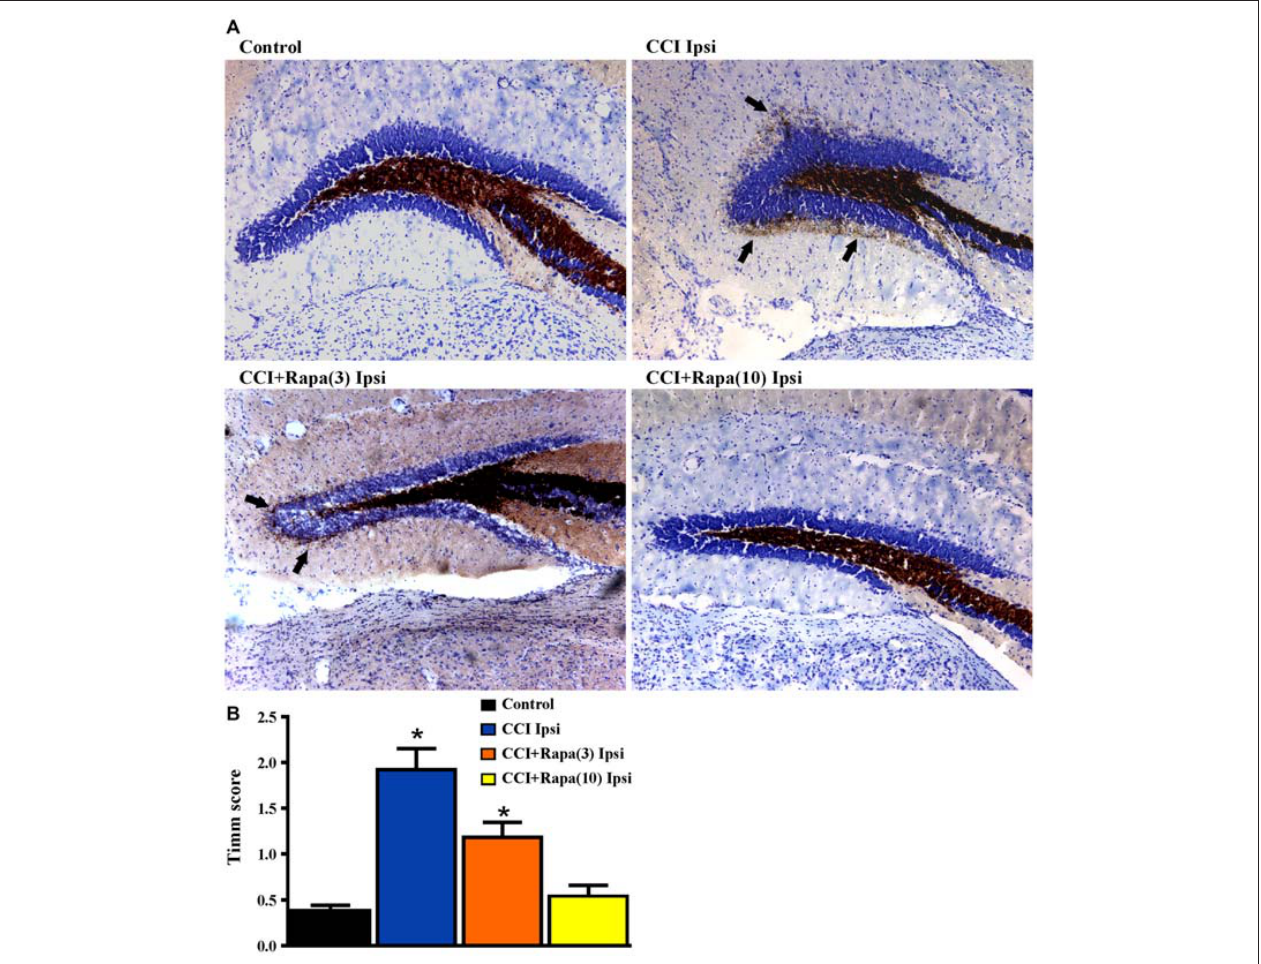
FIGURE 4 | Timm staining in the dentate gyrus 8–13 weeks post-injury from sham-operated control, CCI injured, and CCI-injured with rapamycin treatment groups. (A) Representative images of Timm staining from the four different groups: control, CCI Ipsi, CCI + Rapa(3) Ipsi, and CCI + Rapa(10) Ipsi. (B) Mean Timm scores in control, CCI Ipsi, CCI + Rapa(3) Ipsi, and CCI + Rapa(10) Ipsi groups. The injured hemisphere of both CCI Ipsi and CCI + Rapa(3) Ipsi groups exhibited higher Timm scores relative to the control group. Mice receiving rapamycin treatment (10 mg/kg) after CCI had Timm scores similar to controls. Error bars indicate SEM; ∗ p <